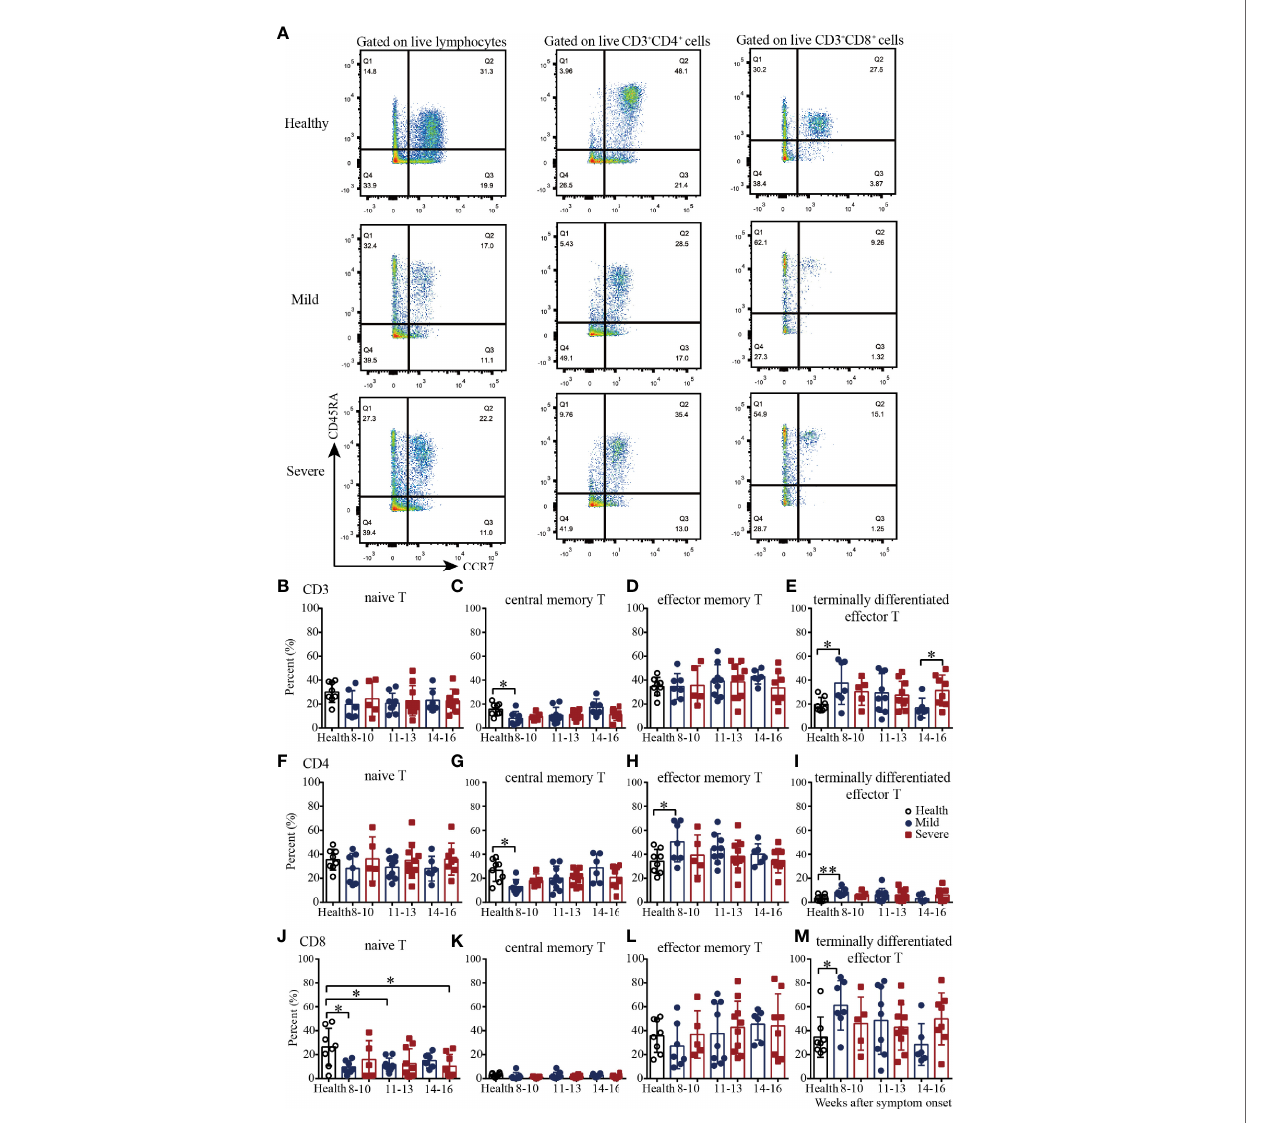
FIGURE 3 | T cell subsets of PBMCs from recovered COVID-19 patients. Representative fl ow cytometry plots showing the expression patterns of different naïve/ memory T-cell subsets in recovered COVID-19 patients (A) . Comparison of the frequencies of naïve (B) , central memory (C) , effector memory (D) , and terminally differentiated effector (E) CD3 + T cells between the mild and severe patients from 8 to 16 weeks after symptom onset. Comparison of the frequencies of naïve (F) , central memory (G) , effector memory (H) , and terminally differentiated effector (I) CD4 + T cells between the mild and severe patients from 8 to 16 weeks after symptom onset. Comparison of the frequencies of naïve (G) , central memory (K) , effector memory (L) , and terminally differentiated effector (M) CD8 + T cells between the mild and severe patients from 8 to 16 weeks after symptom onset (Health, n=8; patient, n=22). *P<0.05;